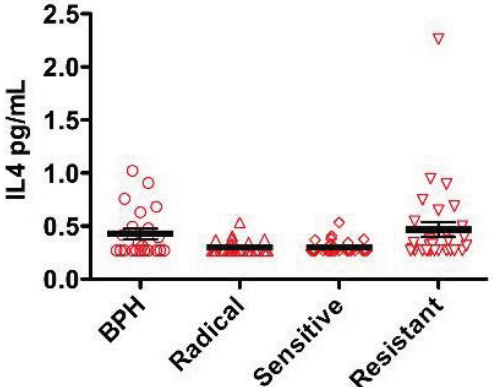
White: 16 Black: 4 Asian: